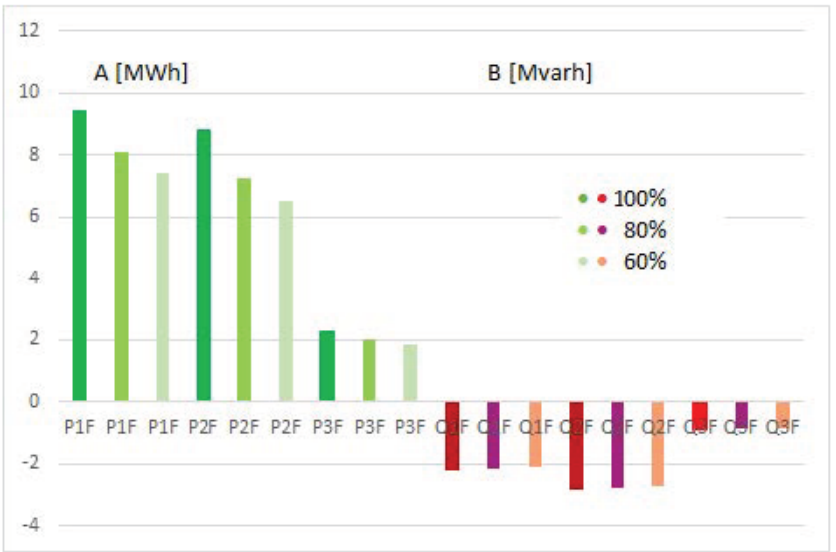
Figure 14. Active and passive energy consumption in 1 circuit of the lighting installation of the luminaire with LED sources (no reduction—100%, with a reduction—80%, with a reduction—60%). Source: own